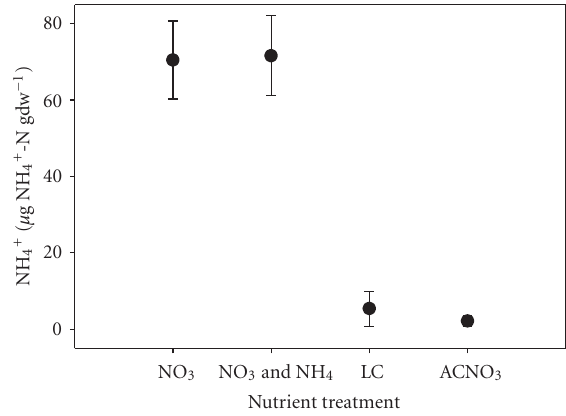
Figure 3: Average increase in NH 4+ concentration ( μ g NH 4 -N per gram dry weight) in Oyster Rake retention pond sediment microcosms (calculated by subtracting NH 4+ concentration at time 0 from NH 4+ concentration at time of sampling) between sampling times 36 hours and 72 hours for 4 di ff erent nutrient treatments (1400 μ g NO 3 -N per vial addition (NO 3 ); 1400 μ g NO 3 -N − + 1000 μ g NH 4 -N per vial addition (NO 3 and NH 4 ); live control with no NO 3 − or NH 4+ addition (LC); abiotic control with 1400 μ g NO 3 - N − addition and no NH 4+ addition (ACNO 3 )). Error bars represent one standard deviation.